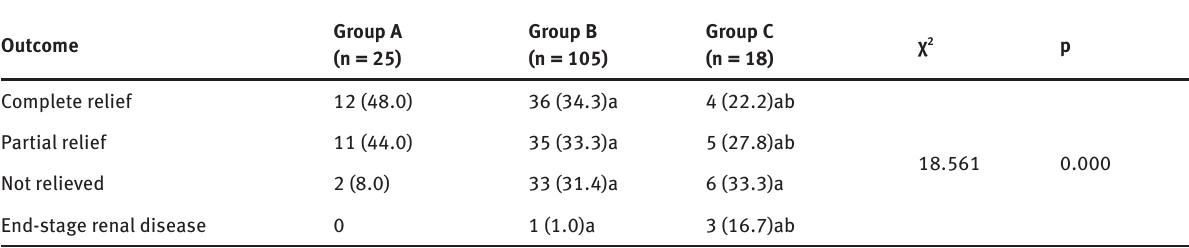
Table 4: Prognosis of the three groups after follow-up in 5 years after treatment.